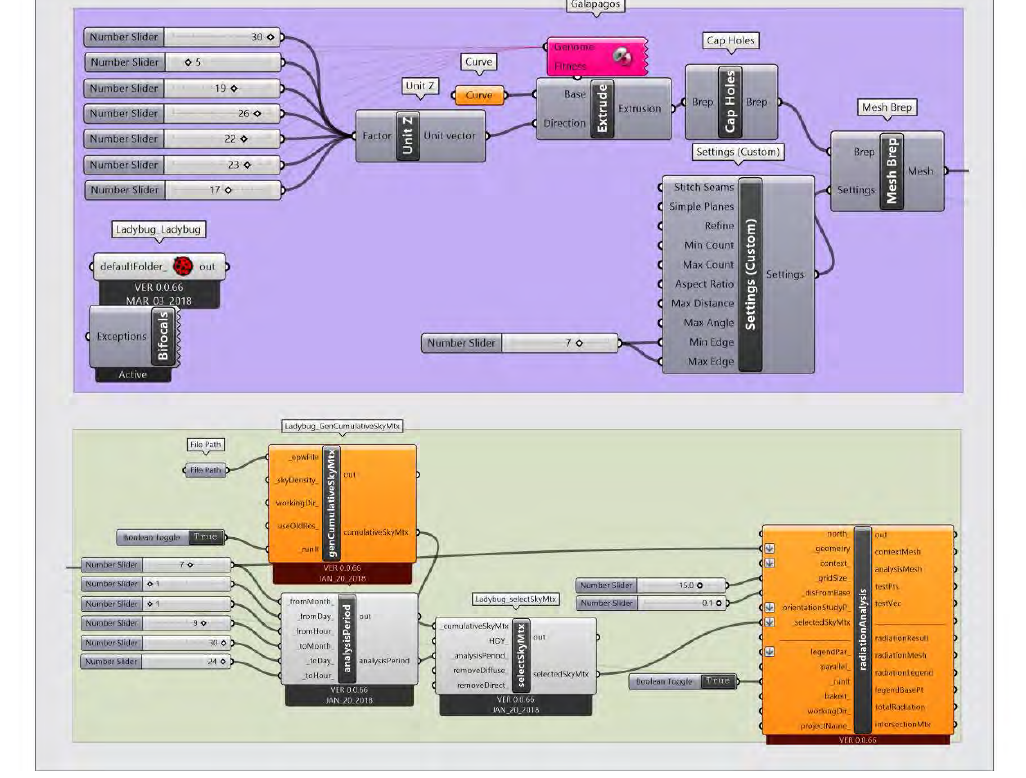
Figure 10 - The final algorithm for solar radiation on a neighborhood and urban block